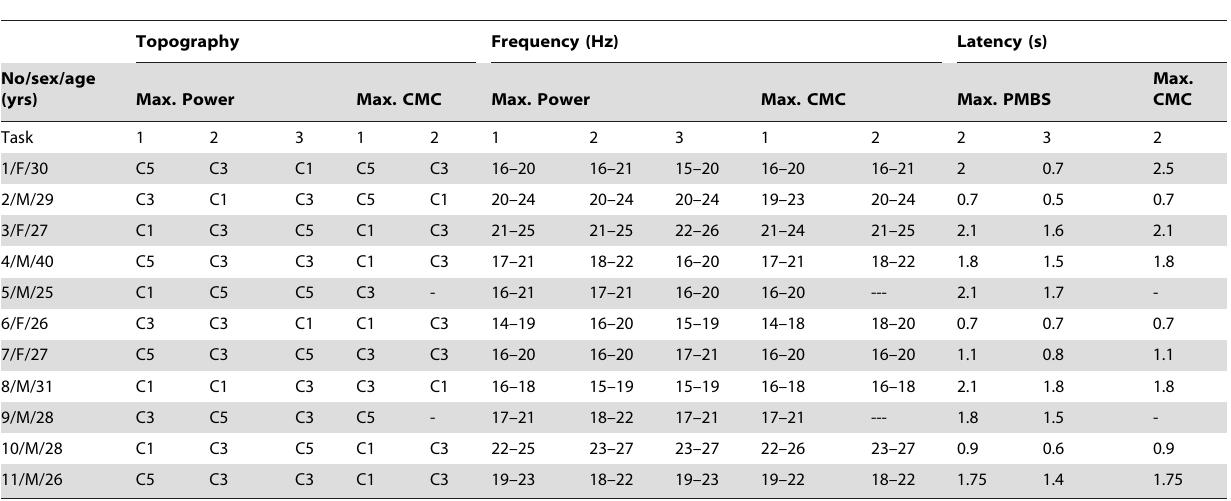
Table 1. Topography, frequency and latency of PMBS and cortico-muscular coherence (CMC) contralateral to the movement in Task1-3.